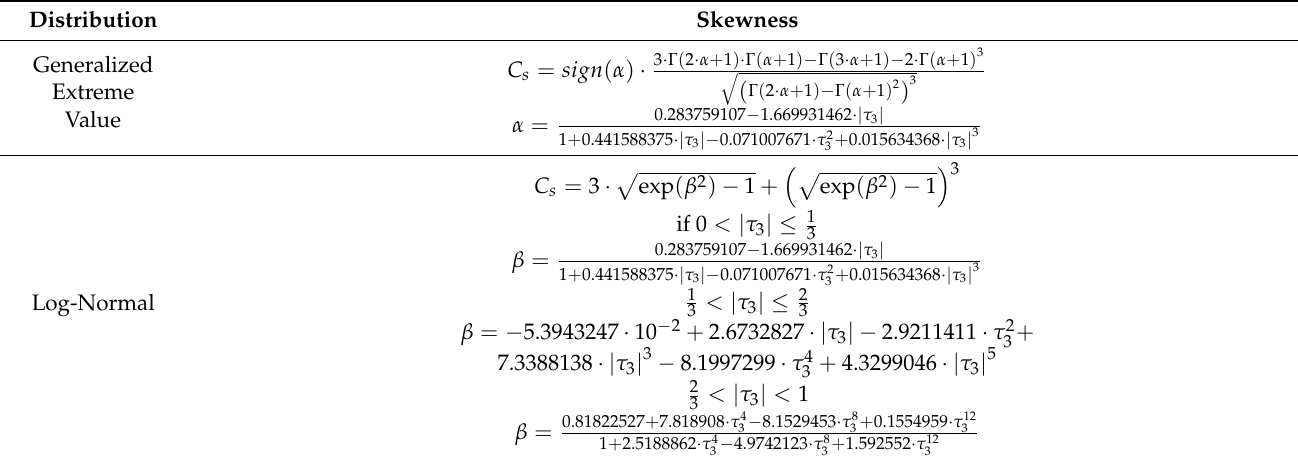
Table A2. Distribution equivalence